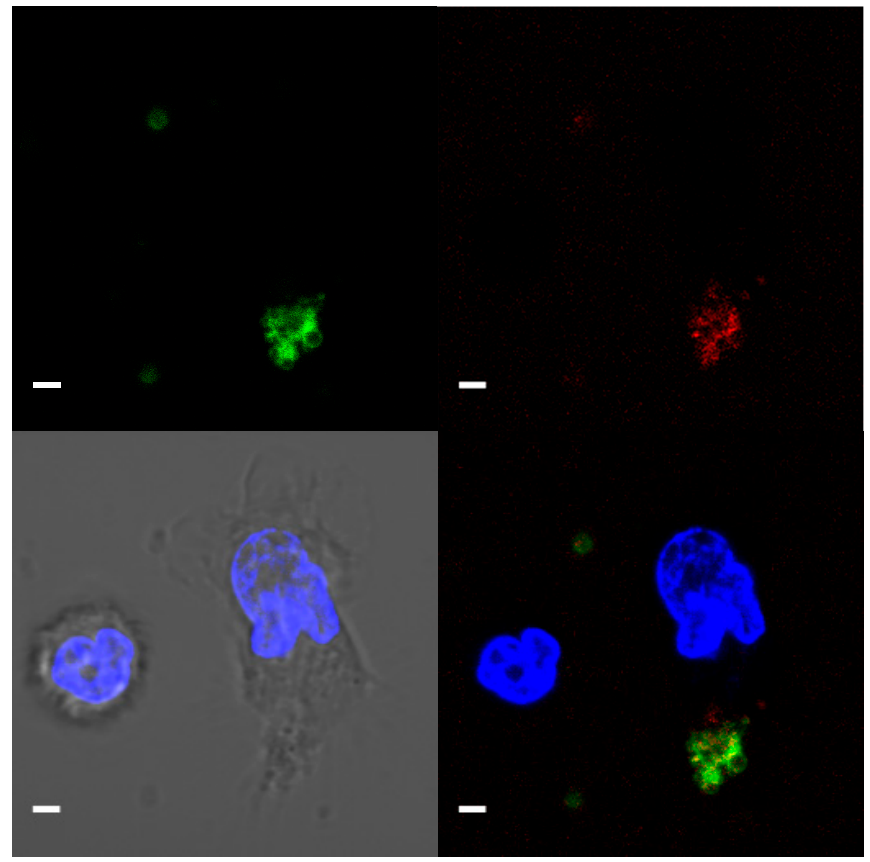
Figure 3. Representative confocal microscopy image (a single focal plane) of T-cadherin on platelets. CD61—green, T-cadherin—red, DNA (Hoecst 33342)—blue. Live platelet and nucleated blood cells. Scale bar (white line) 2 μ m. Thus, the antibody BAF3264 did not cross-react with the surface of THP-1, CHO, leukocytes, and specifically bound with platelets, MEG-01, and HUVEC.